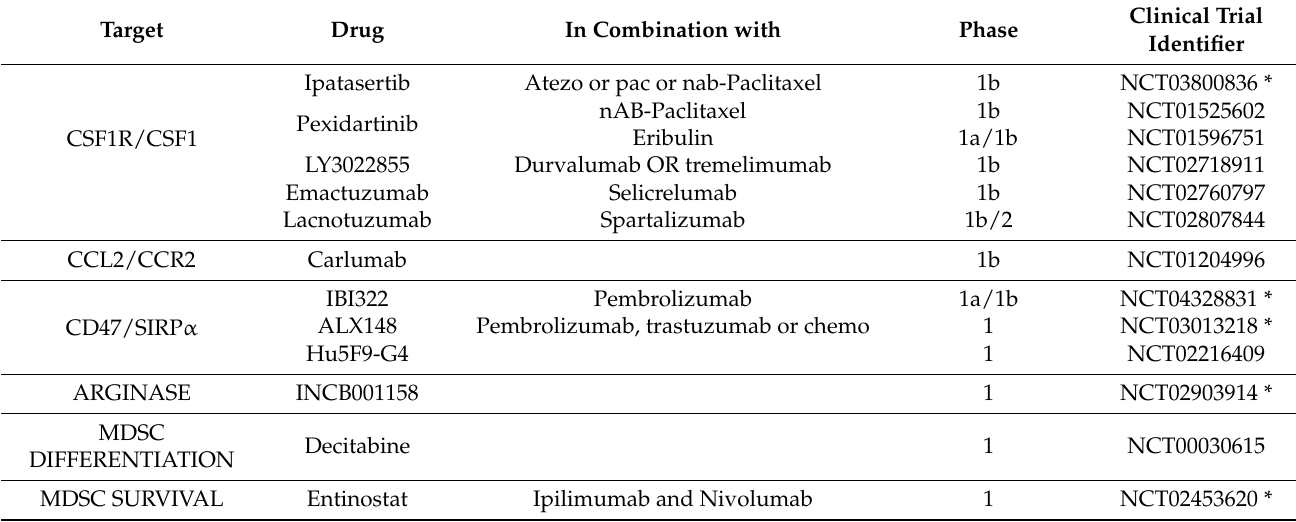
Table 1. Drugs targeting TAMs and myeloid-derived suppressor cells (MDSCs) in clinical trials for breast